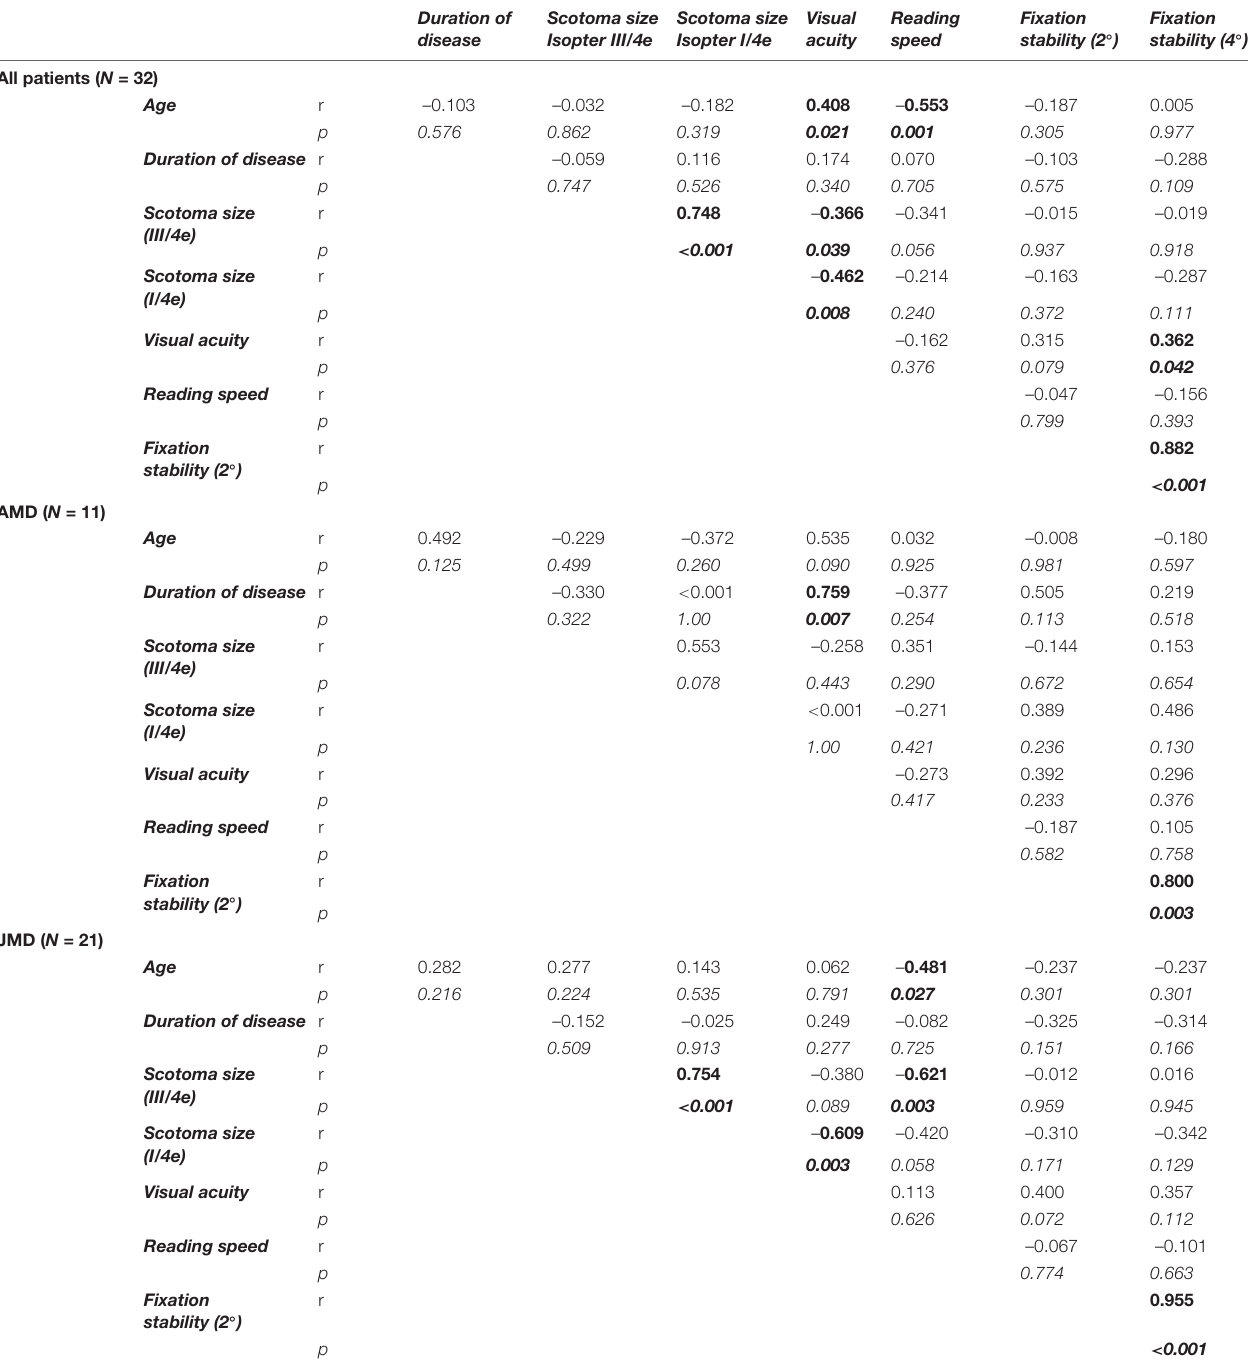
TABLE 2 | Pearson correlation coefficients (r) together with their respective p -values (italic values, p ) of demographic and behavioral measures (two-sided), for the whole group of patients ( N = 32) and for the subgroups (AMD, N = 11; JMD, N = 21),